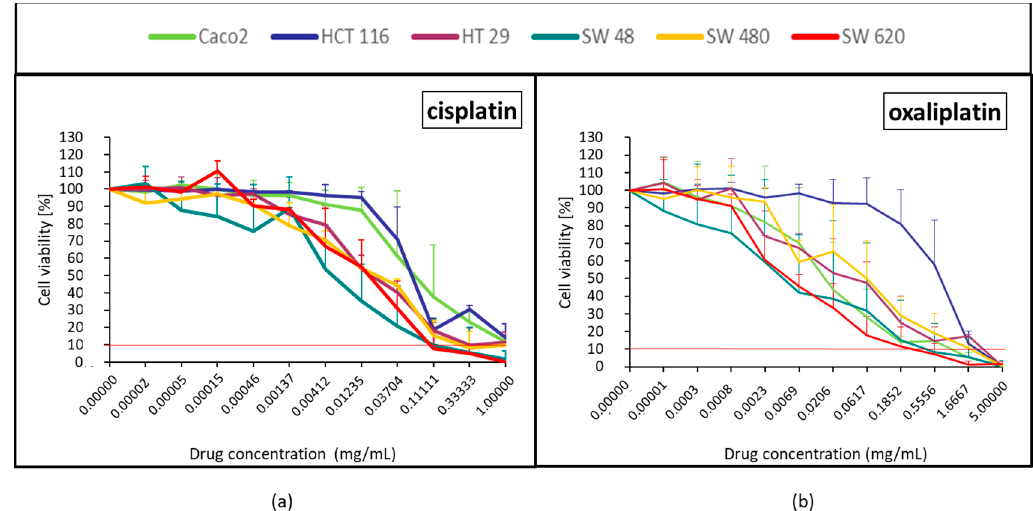
Figure 3. Colorectal cancer cell line viability curves (mean ± standard deviation) after a 30 min contact time with the 2 platinum derivatives: cisplatin ( a ) and oxaliplatin ( b ). The horizontal red line represents 10% of cell viability. The results are presented after normalization with the control cells (untreated condition).